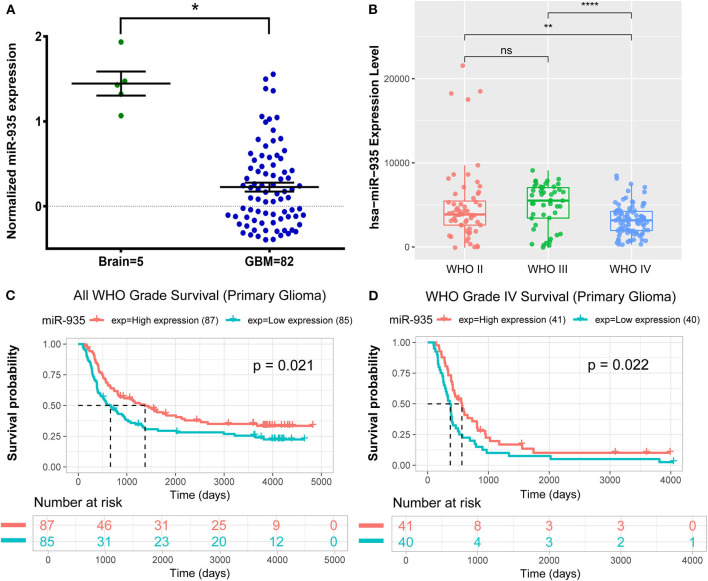
MicroRNA 935 (miR-935) is downregulated in glioblastoma (GB) tissues that are associated with poor prognosis. (A) The expression of miR-935 in GB tissues (n = 82) and in the normal brain tissues (n = 5) in the GSE25631 dataset. (B) The expression of miR-935 in the WHO grade II/III/IV gliomas in Chinese Glioma Genome Atlas (CGGA) microRNA_array_198 dataset. The Kaplan–Meier curve of overall survival (OS) stratified by the miR-935 level (high and low expression divided by the median expression level) in all grades of gliomas, (C) grade IV gliomas, (D) *p < 0.05, **p < 0.01, ****p < 0.001 in the unpaired Student's t-test.